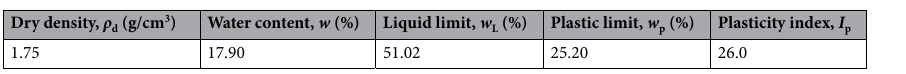
Table 2. Physical parameters of the soil in CSCN.